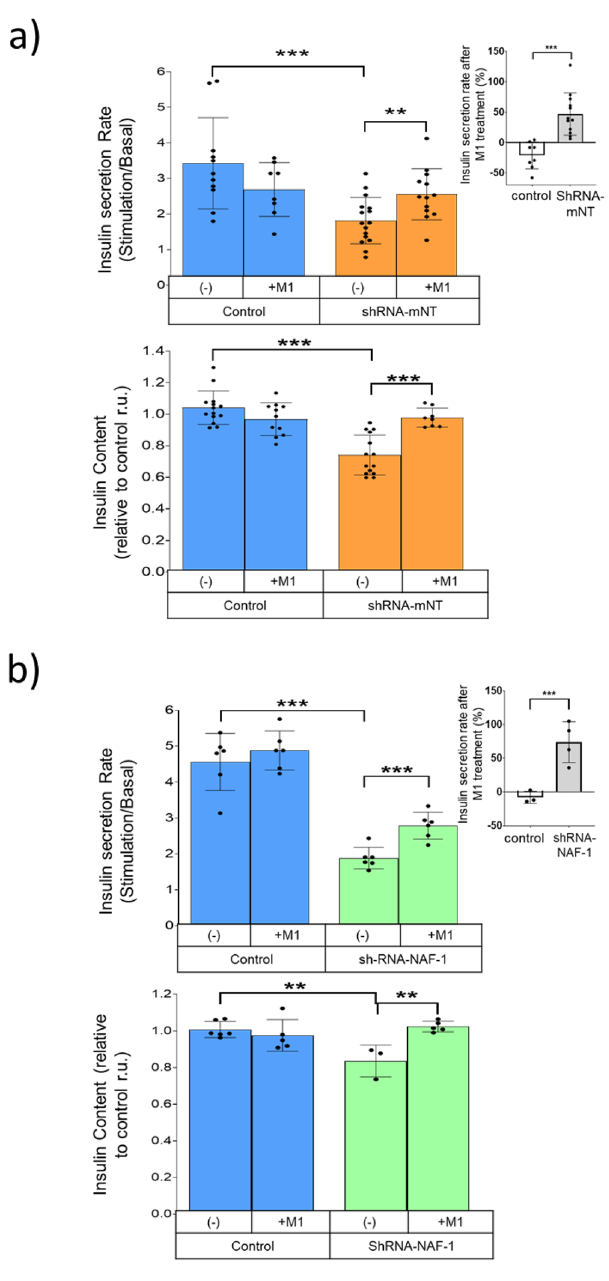
Fig. 3 M1 restores the decreased insulin content and secretion of INS-1E β -cells with suppressed expression of mNT and NAF-1 NEET proteins. a (Upper) Insulin secretion rate of INS-1E cells with suppressed mNT expression (shRNA-mNT/orange) and cells expressing wild type levels of mNT (blue) following treatment with or without 5 µ M of M1. Upper right graph shows the percentage of insulin secretion rate change from the different cells indicated after M1 molecule treatment. (Lower) INS-1E cell Insulin content measurements relative to untreated control following treatment with or without 5 µ M M1. **P < 0.01, ***P < 0.001. n = 6. b (Upper) Insulin secretion rate of INS-1E cells with suppressed NAF-1 expression (shRNA-NAF-1/green) and cells expressing normal levels of NAF-1 (blue) following treatment with or without 5 µ M of M1. Upper right graph shows the percentage of insulin secretion rate change from the different cells indicated after M1 treatment. (Lower) INS-1E cell Insulin content measurements relative to control levels following treatment with or without 5 µ M of M1. **P < 0.01, *** P < 0.001. n =